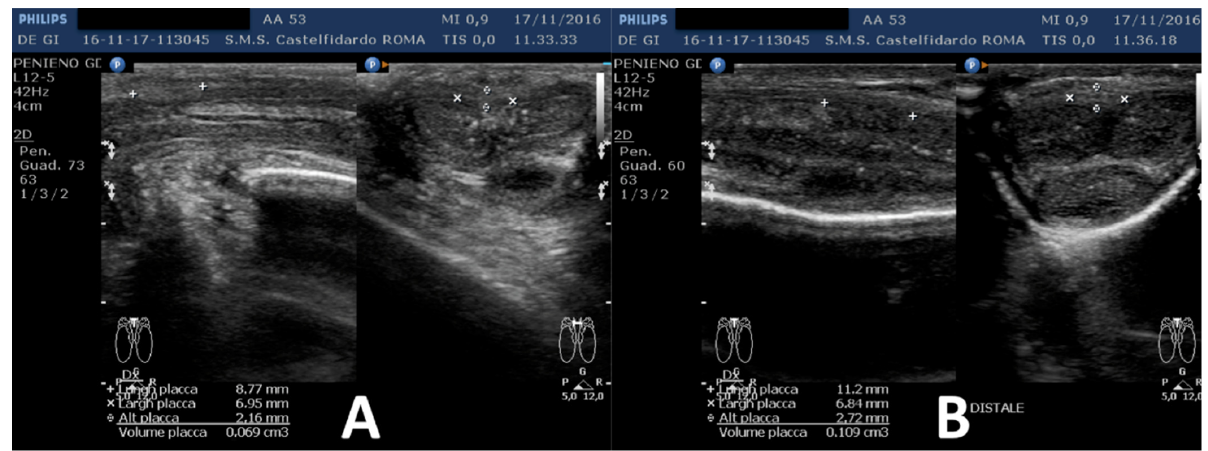
Figure 8. Ultrasonography of the penis after the second treatment cycle. ( A ) First plaque, ( B ) second plaque.